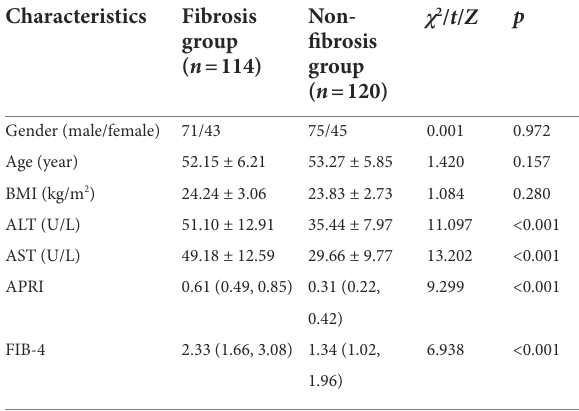
TABLE 1 Comparison of demographic and clinical characteristics between fibrosis and non-fibrosis group.